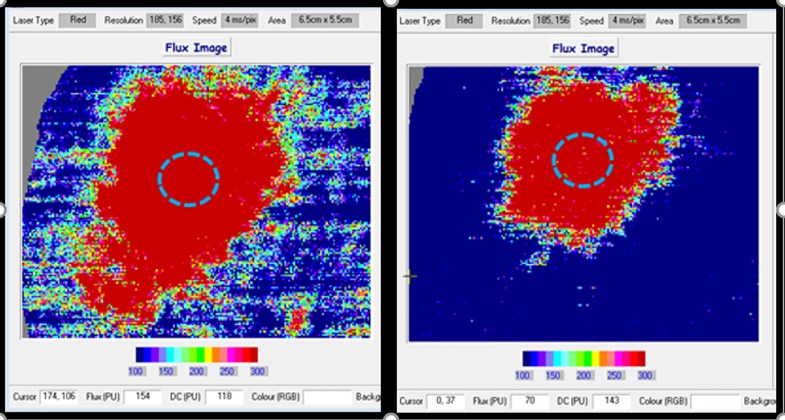
LDIFLARE images.The image on the left is from a 22-year old HC with LDIFLARE at 12.44 cm2 (>75th centile) while image on the right is from a 75-year old HC with LDIFLARE at 5.17 cm2 (<25th centile).